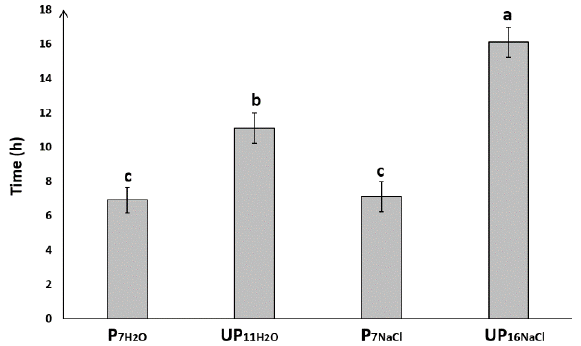
Figure 1. Time to reach 1% germination, (primed seeds germinating 7 h in water, P 7H 2 O ; unprimed seeds germinating 11 h in water, UP 11H 2 O; primed seeds germinating 7 h in NaCl, P 7NaCl ; unprimed seeds germinating 16 h in NaCl, UP 16NaCl ). The differences were statistically significant, as deter- mined by one -way analysis of varianc e (ANOVA) and Tukey –Kramer multiple comparison test ( n = 10, p < 0.05). The vertical bars denote SD. The same letters on bars describe not significant differ- ences between means.